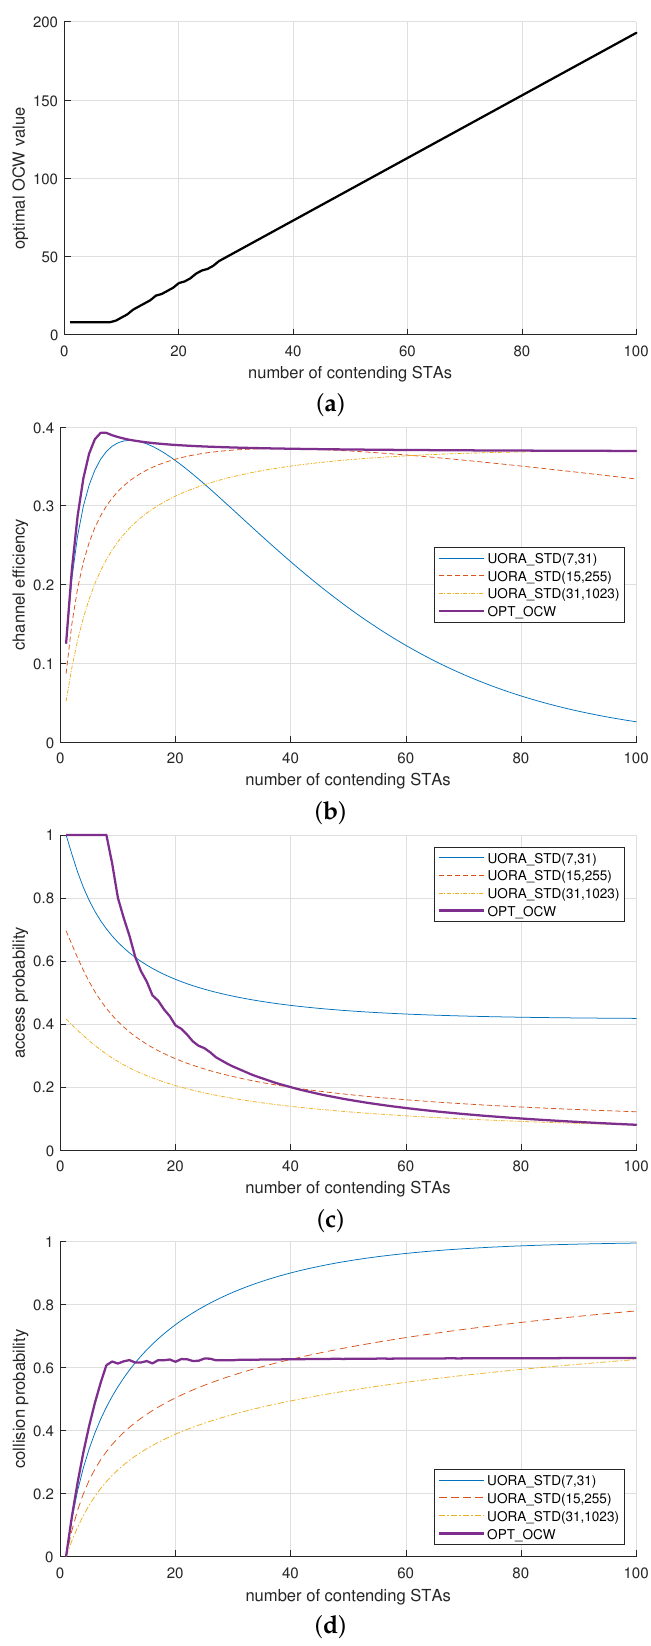
Figure 2. Analysis of the OCW effect in UORA: ( a ) the optimal OCW value, ( b ) channel efficiency, ( c ) access probability, and ( d ) collision